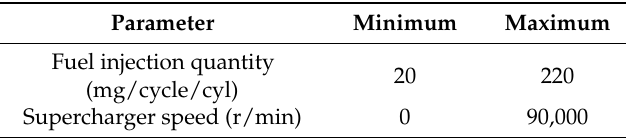
Table 3. Input parameters for